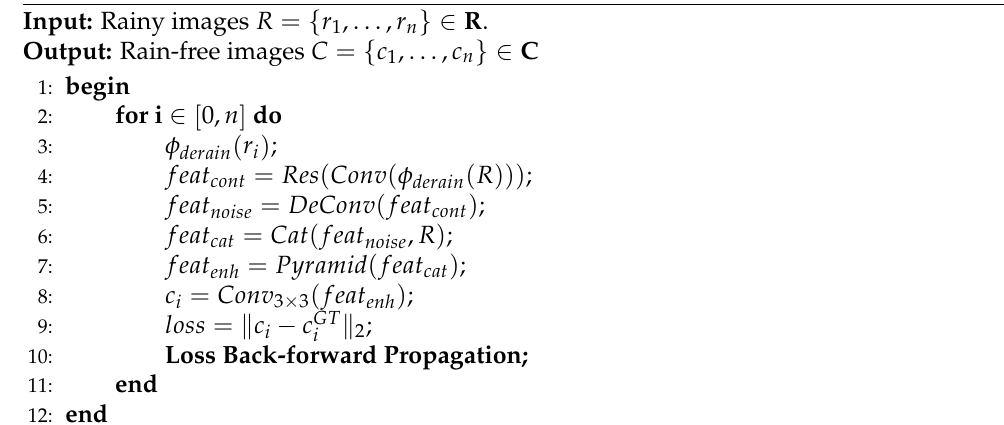
Algorithm 1 The pipeline of image deraining with the Deraining